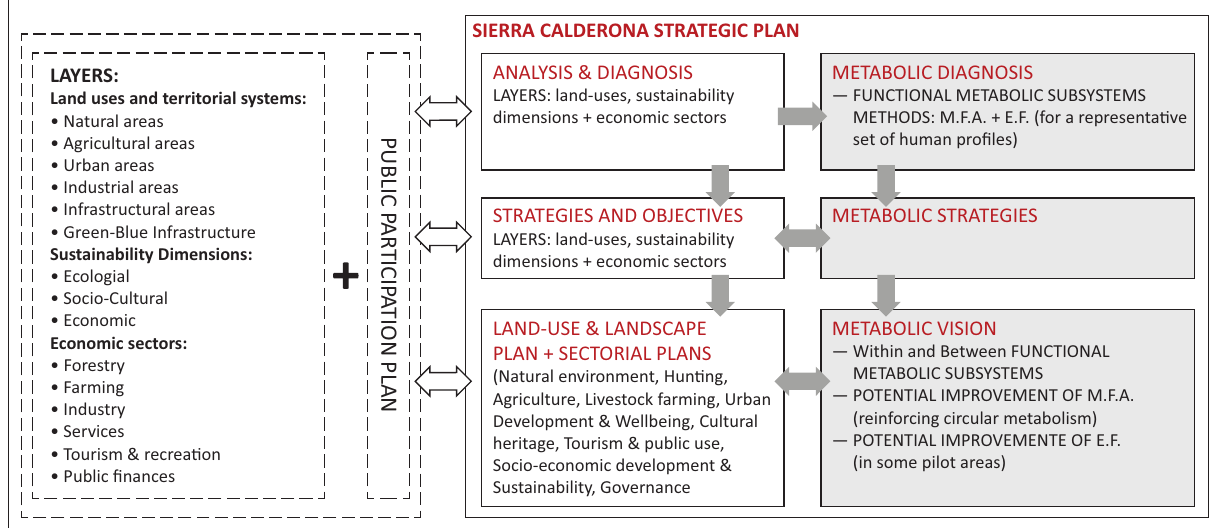
Figure 2. Contents of the SCSP and use of metabolic studies. During the second phase, the strategies and objec- tives of the SCSP were formulated based on the out- comes of the first phase and the metabolic assessment of the Sierra